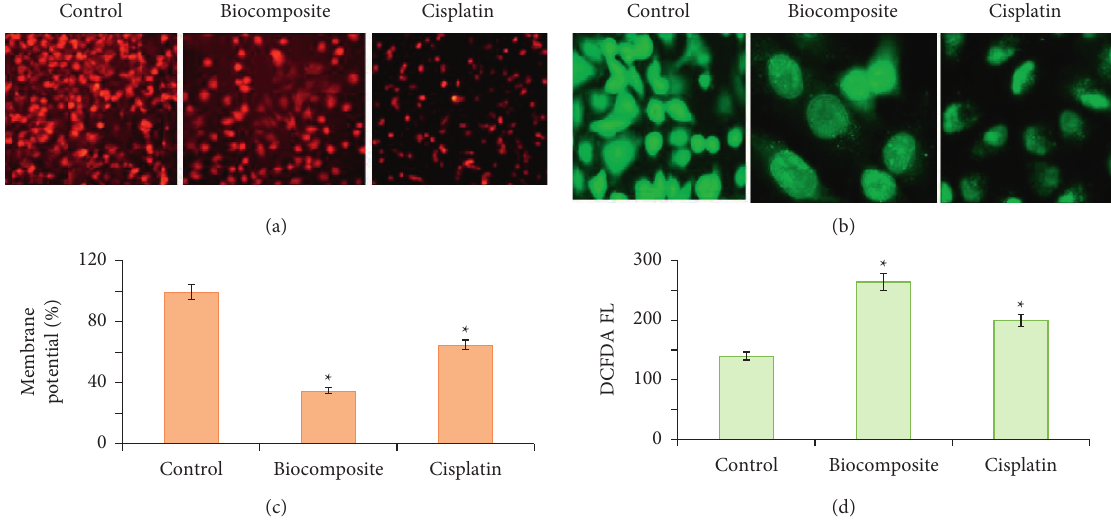
Figure 11: (a) Fluorescence microscopic images of A549 cells treated with JC-1 staining to assess the mitochondrial membrane potential ( ΔΨ m) of polymeric bionanocomposite-treated cells after 24h incubation in contrast to cisplatin (40x); (b) histograms demonstrating the percentage of cells with disrupted MMP; (c) fluorescence microscopic images of CM-H2 DCFDA-treated A549 cells, intracellular ROS indicator after treatment with polymeric bionanocomposite; (d) fluorescence spectroscopy for quantification of the ROS level. Data are displayed as mean ± SD of triplicate measurements.